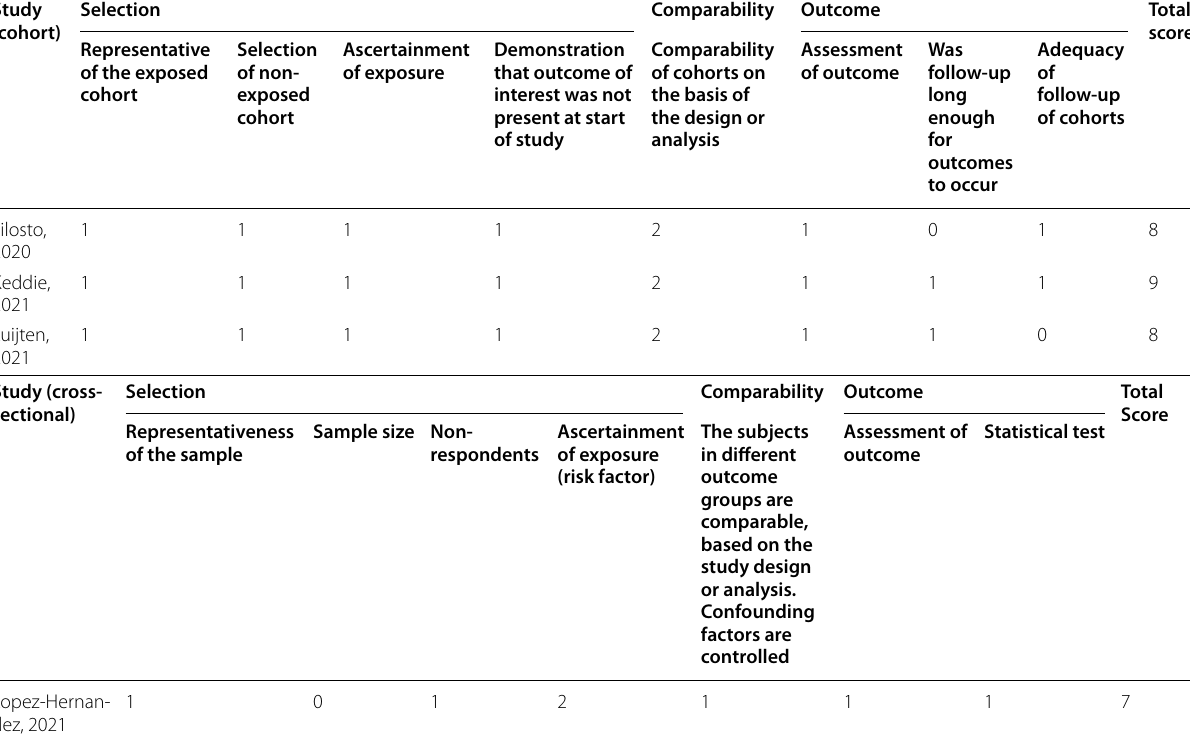
Table 1 Assessment of study quality based on the Newcastle–Ottawa Scale (NOS) Study (cohort)